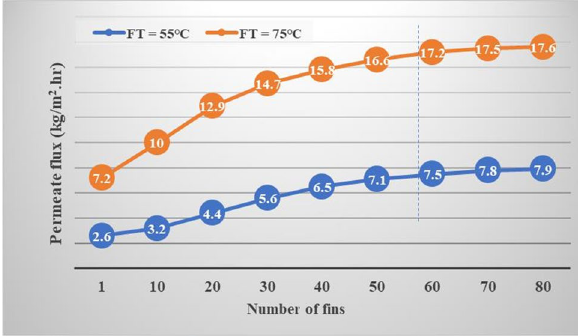
Fig. 12 Effect of increase in number of fins on permeate